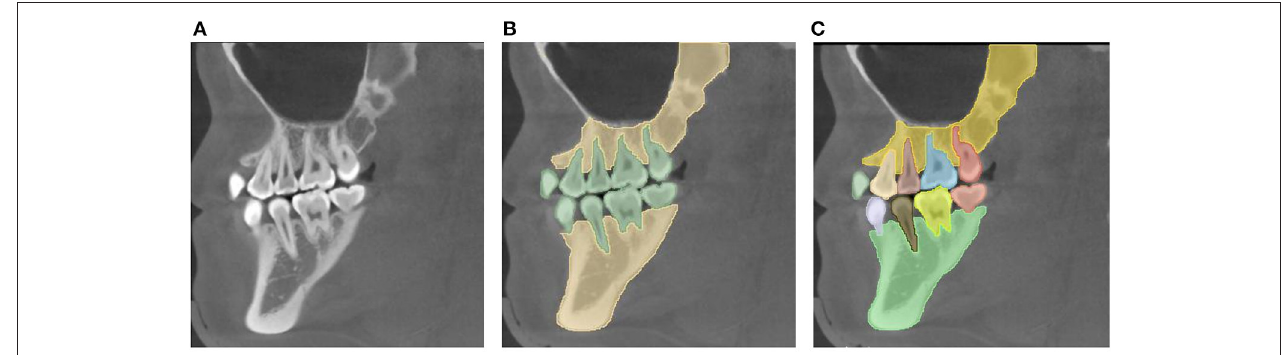
FIGURE 1 | Task definitions for automatic image segmentation. (A) The original image. (B) Semantic segmentation: it is required to segment the teeth, jaws, and background, without the need to distinguish the individuals in the category “Tooth” or “Jaw.” (C) Instance segmentation: not only the category label is required, but also the instance label among the same class is needed, i.e., separating the individuals in the category “Tooth” or